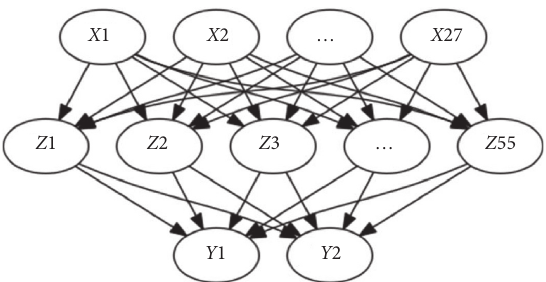
Figure 10: BP neural network